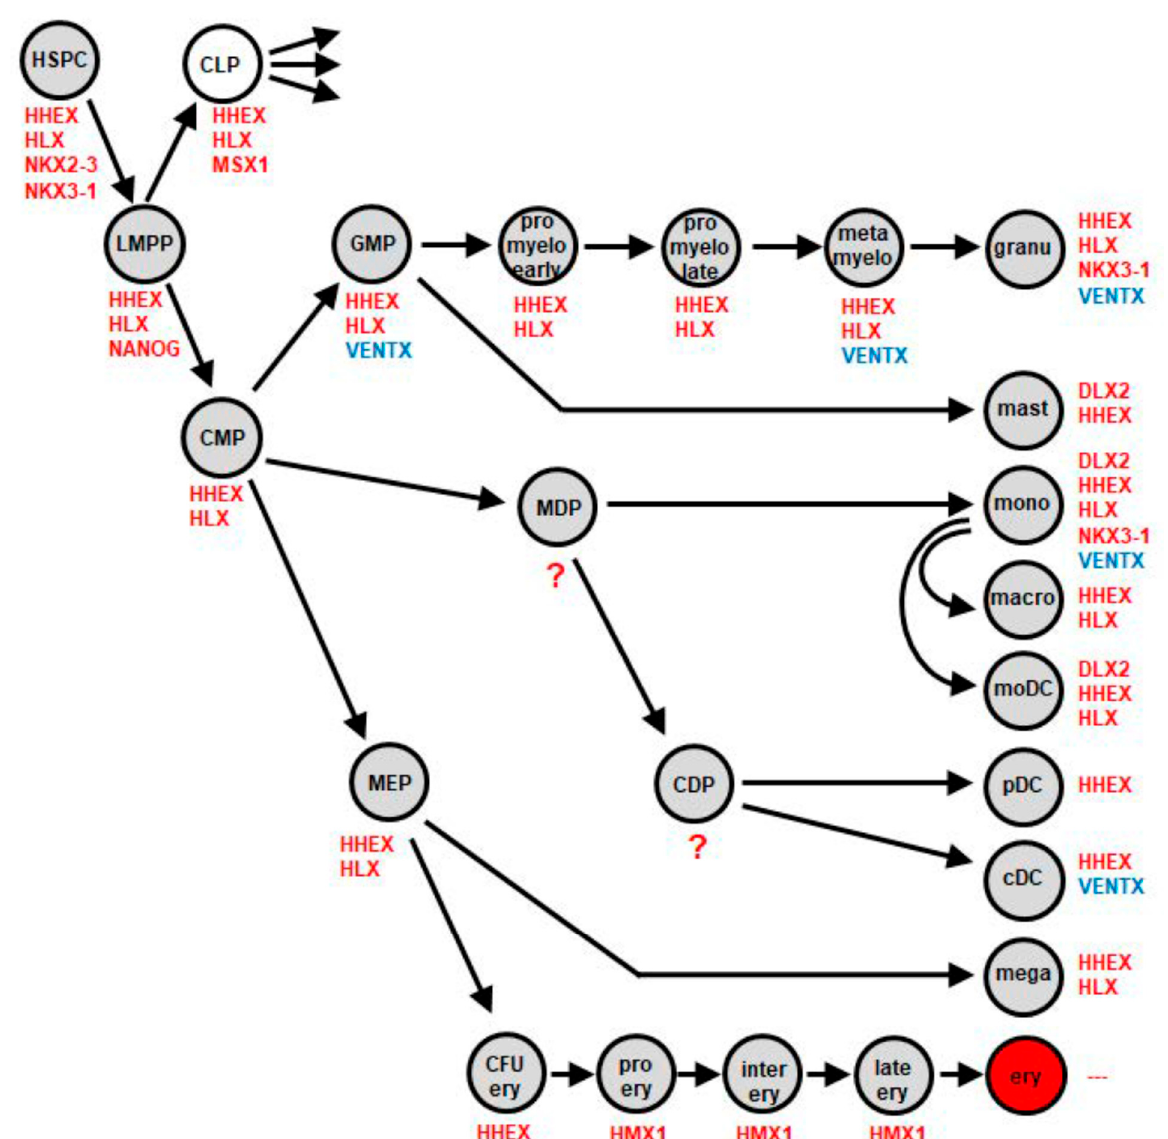
Figure 2. Myeloid NKL-code containing progenitor-derived DCs. This scheme shows the updated myeloid NKL-code and summarizes published data [7] with results from this study for progenitor-derived DCs including pDCs and cDCs. NKL homeobox gene VENTX is indicated in blue. cDC: conventional dendritic cell, CDP: common dendritic cell progenitor, CFU ery: colony forming unit for erythrocytes, CLP: common lymphoid progenitor, CMP: common myeloid progenitor, ery: erythrocyte, GMP: granulocyte and mast cell progenitor, granu: granulocytes, HSPC: hematopoietic stem and progenitor cell, LMPP: lymphoid and myeloid primed progenitor, macro: macrophage, MDP: monocyte and dendritic cell progenitor, mega: megakaryocyte, MEP: megakaryocyte and erythrocyte progenitor, moDC: monocyte-derived dendritic cell, mono: monocyte, pDC: plasmacytoid dendritic cell.